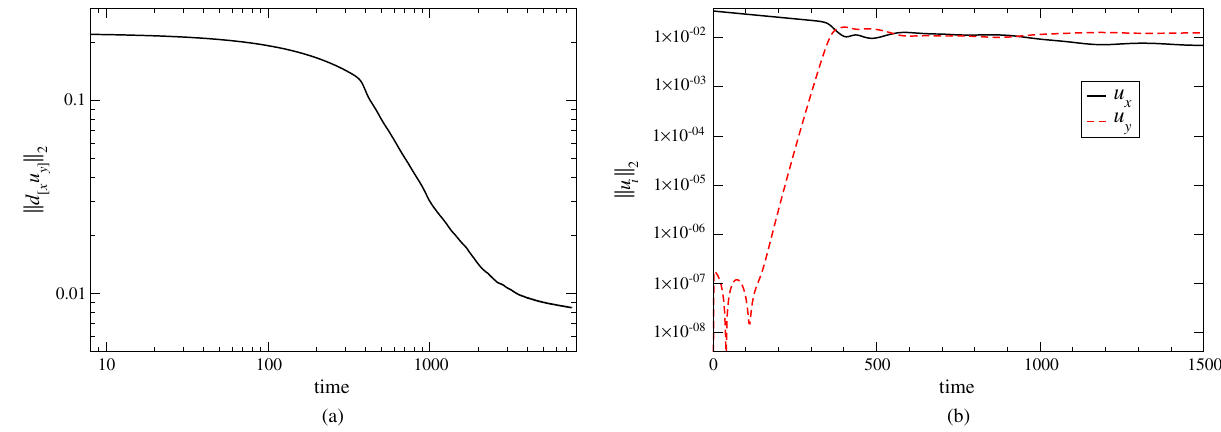
FIG. 2. L norms of (a) vorticity and (b) u 2 exponential decay, followed by a power law during the inverse cascade, followed by a slower exponential decay. In (b) u exponentially until it is of similar amplitude to u